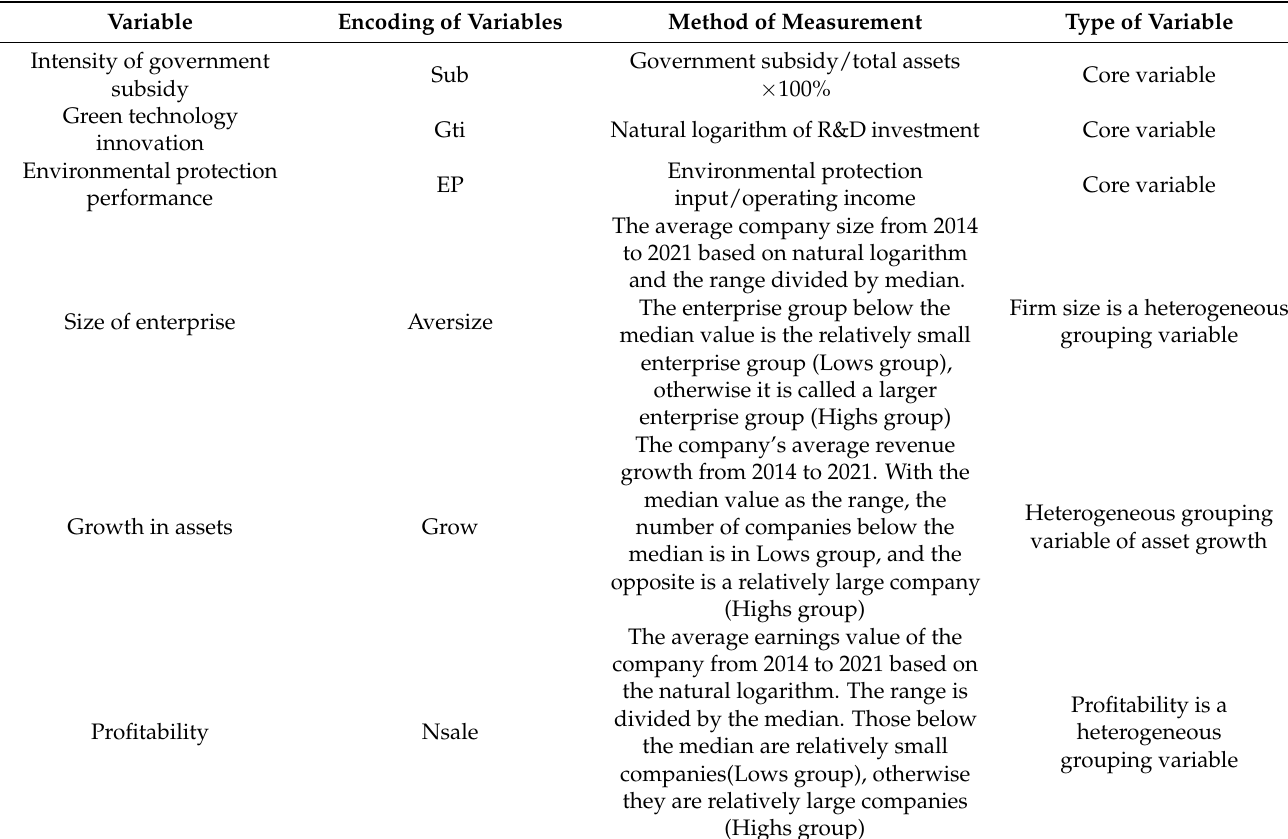
Table 1. Summary of